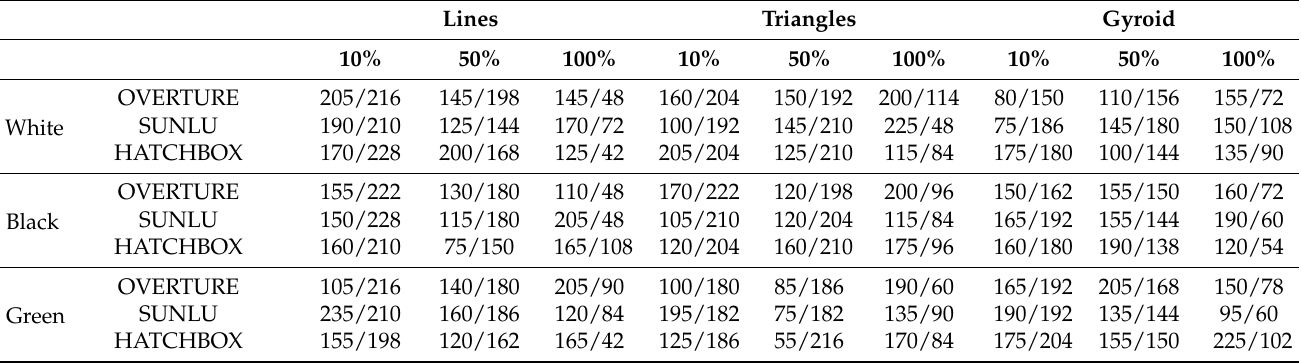
Table 4. Filament scoring across all nine printer conditions, with varying infill density and infill pat- tern, based upon dimensional accuracy and mechanical properties ( S Dimension and S Property separated as S Dimension / S Property